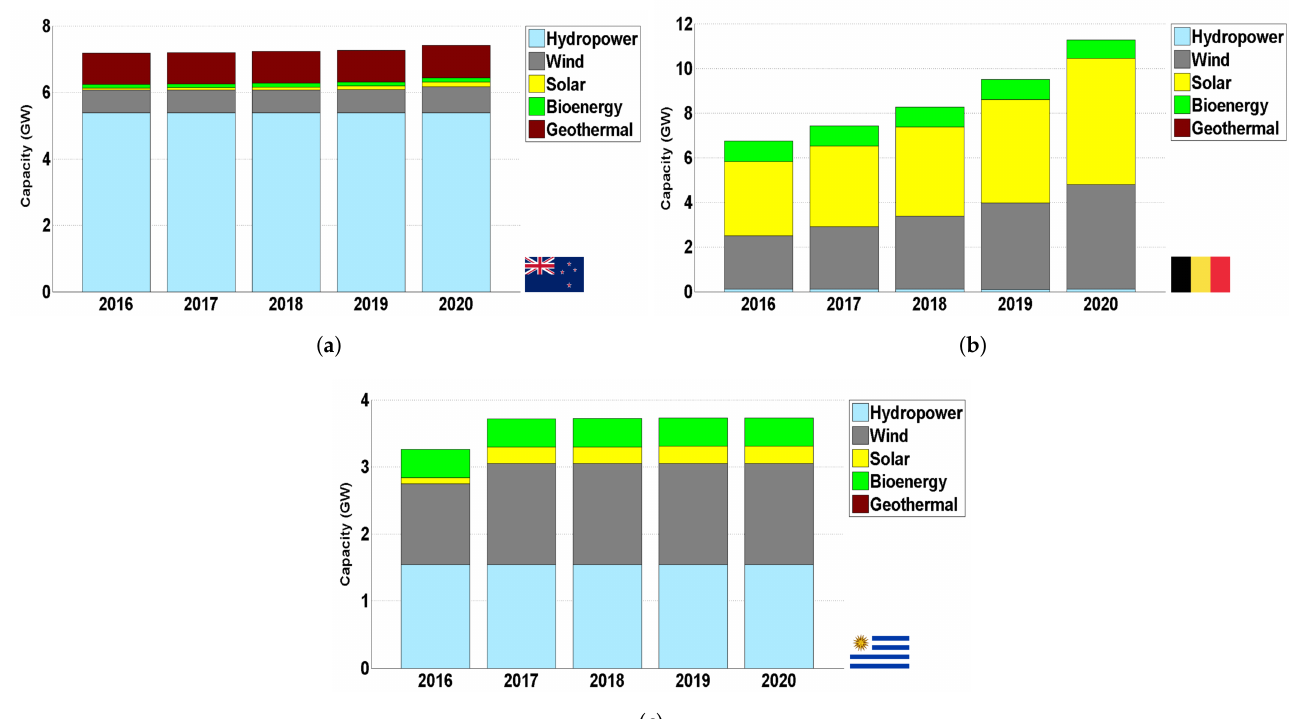
Figure 1. Cumulative installed capacity of RES in three countries located in various continents in the years 2016 to 2020 [29]: ( a ) New Zealand. ( b ) Belgium. ( c )